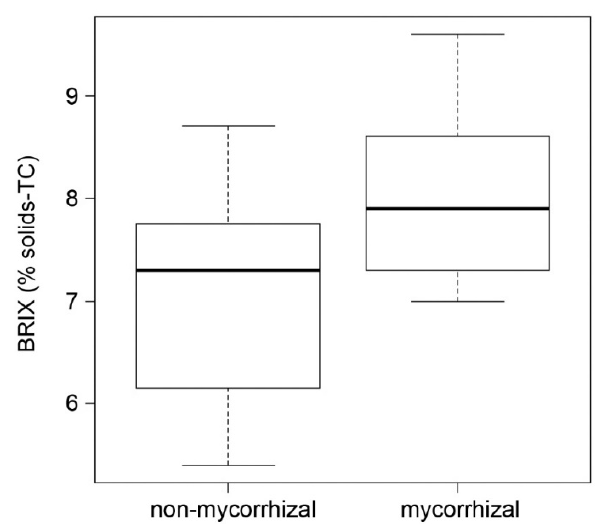
Figure 4. BRIX values of red fruits of non-mycorrhizal and mycorrhizal plants. BRIX was determined as a percentage of solids, temperature compensated (TC). Boxplots show medians (cross bar), 25–75% interquartile range (boxes) and data distribution (error bars). Students t -tests revealed no significant differences between both data sets ( p = 0.08, n = 8). Table 2. Contents of selected carotenoids in fruits from non-mycorrhizal and mycorrhizal plants. Carotenoid 1